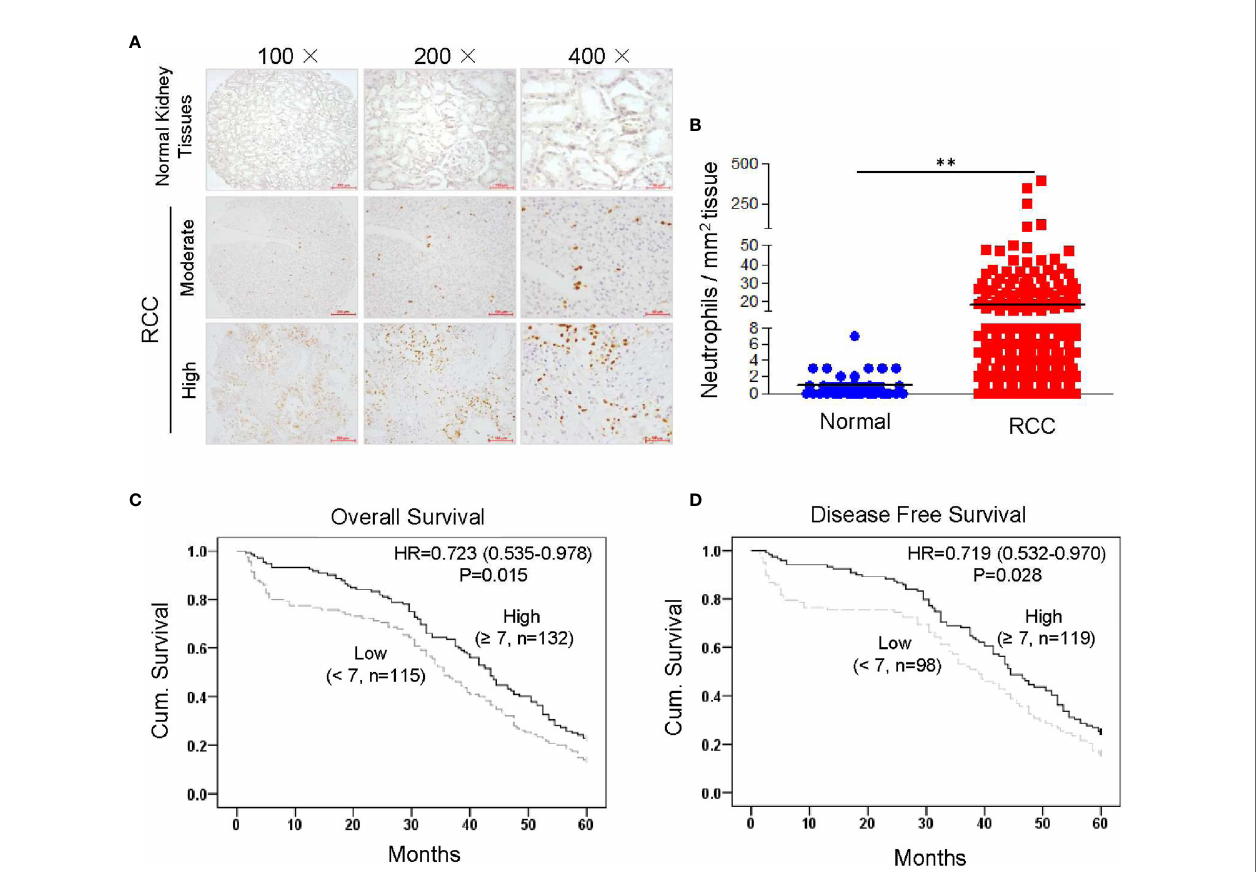
FIGURE 1 | Higher levels of tumor-in fi ltrating neutrophils are correlated with improved clinical outcome in RCC patients. Tissue microarray slides, including 307 RCC tissues and 70 normal kidney tissues, were analyzed by IHC staining with anti-human MPO monoclonal antibody. MPO-positive neutrophils were counted and analyzed. The correlation between in fi ltrated neutrophils and prognosis was analyzed by constructing Kaplan-Meier survival curves with collected clinical information ( n = 247, follow-up time = 60 months). Data are shown as the mean values ± SEM. ** P <0.01. (A) Representative IHC staining results showing in fi ltrated neutrophils in RCC tissues and normal kidney. (B) Quantitative analysis of in fi ltrated neutrophils in normal kidney or RCC tissues (cell counts in 1 mm 2 tissue). (C) High neutrophil in fi ltration correlated with better 5-year OS in 247 renal cell carcinoma patients ( p = 0.015, log-rank test). (D) High neutrophil in fi ltration correlated with better 5-year disease-free survival in 217 renal cell carcinoma patients ( p = 0.028, log-rank